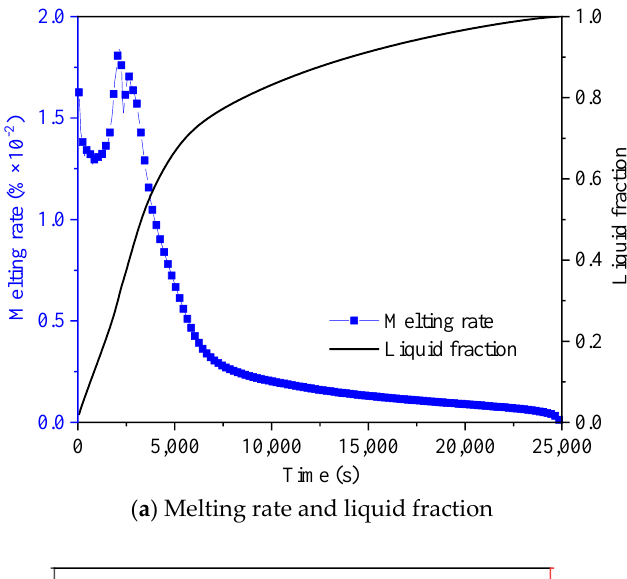
Energies 2022 , 15 , x FOR PEER REVIEW 9 of 24